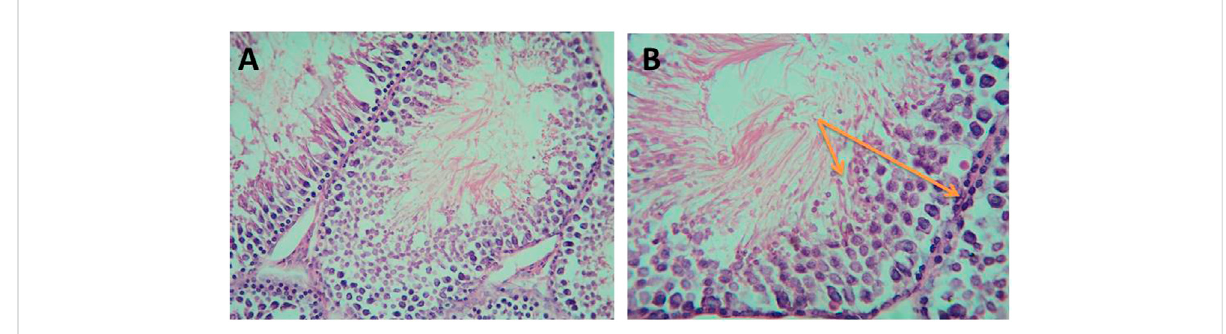
FIGURE 10 Micrograph of control albino rat testes showing normal seminiferous tubule lined with thick germinal epithelium containing different stages of spermatogenic cells (orange arrows) and supportive Sertoli cells with many sperms in the lumen. The interstitial connective tissue contains Leydig cells and fi broblasts (H&E; (A) -X200, (B) -X400).